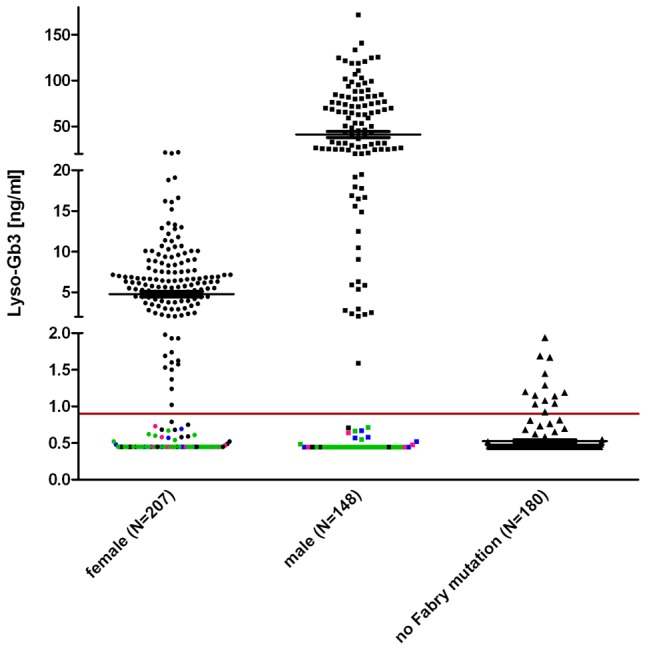
Lyso-Gb3 values for female and male Fabry patients compared to control.The horizontal mark indicated the median. It is noteworthy that lyso-Gb3 levels in males are ∼10 times higher than in females. Each data point represents one patient. Indicated in pink are patients with the mutation p.S126G (8f/4m), in blue p.A143T (10f/8m) and in green p.D313Y (33f/24m) to illustrate that most found non-pathogenic mutations belong to either one or the other patient cohort. Other exceptions are: p.R118C, p.V316I, p.E418G (one male patient each) and p.A20P, p.D83N, p.I91T, p.S102L, p.R112C, p.R118C, p.D175E, p.G325S, p.A368T, p.T385A, p.W399*, c.1208delT, p.L415F, (one female patient each) and p.R252T (4×), p.N215S (3×). About 180 healthy probands were tested with no Fabry gene variation and had values of 0.9 ng/ml (95th percentile calculation).